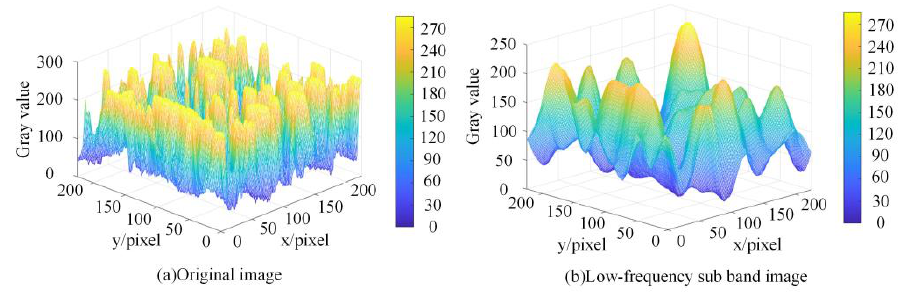
Figure 3. Working condition 1: Three-dimensional display of bubble image.